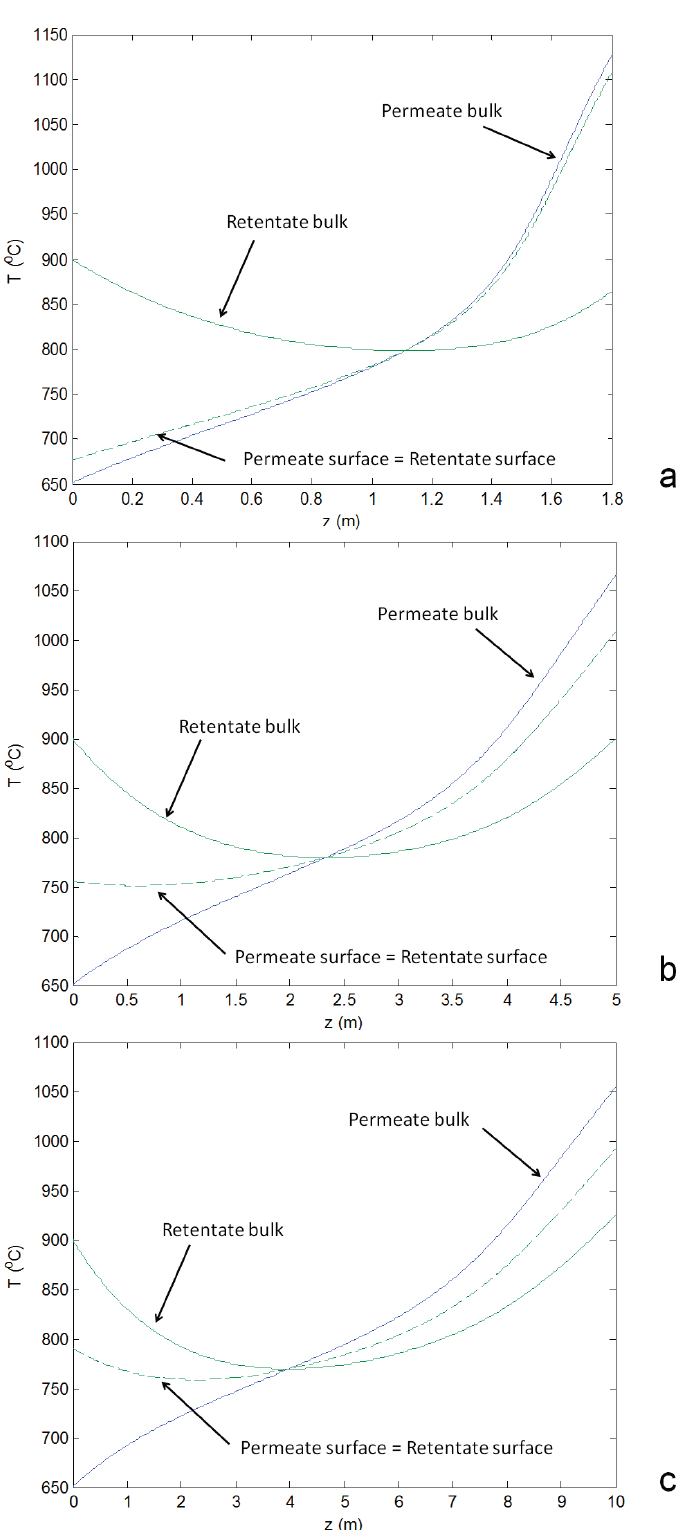
Figure 6. Axial temperature profiles of the gas streams and the membrane surface: ( a ) small size reactor; ( b ) medium size; ( c ) big size reactor. Continuous lines are related to the bulk phase and dashed lines are related to the membrane surface at retentate (green) and permeate (blue)